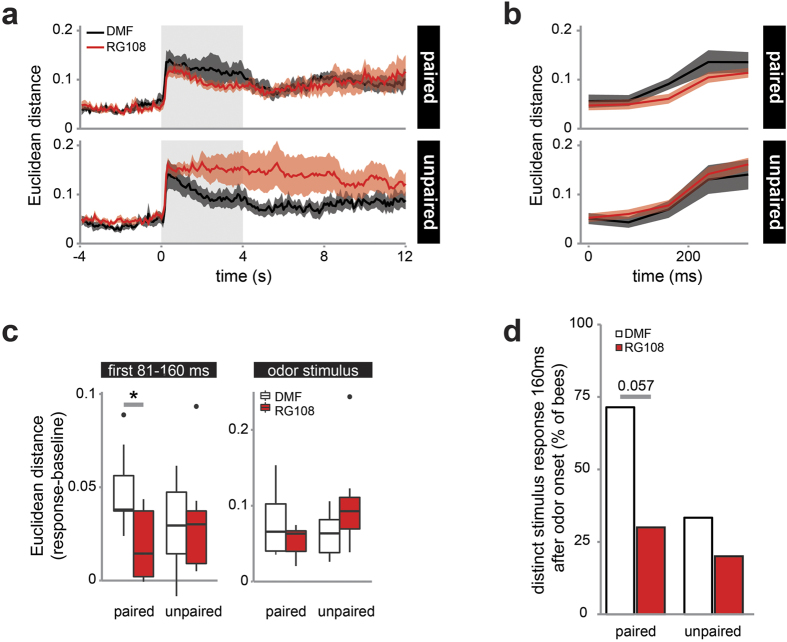
Dnmt inhibition impairs fast odor response pattern separation.(a) Odor stimuli (shaded area) elicited significant responses in all groups (Euclidean distance as dissimilarity measure, mean +/− SEM). (b) Odor-specific patterns established at a slower pace when Dnmts were inhibited: 81–160 ms after odor onset dissimilarity was smaller in the paired/RG108 group. (c) The Euclidian distance was significantly different between treatments in the paired, but not the unpaired group. There was no difference when considering the entire odor stimulus. (d) More bees established distinct odor response patterns (Euclidean distance >3× SD of baseline) within the first 160 ms after odor onset in paired control bees, compared to paired RG108 treated bees. Number of bees: paired: n(RG108) = 10, n(DMF) = 7; unpaired: n(RG108) = 10, n(DMF) = 6; *is p < 0.05.